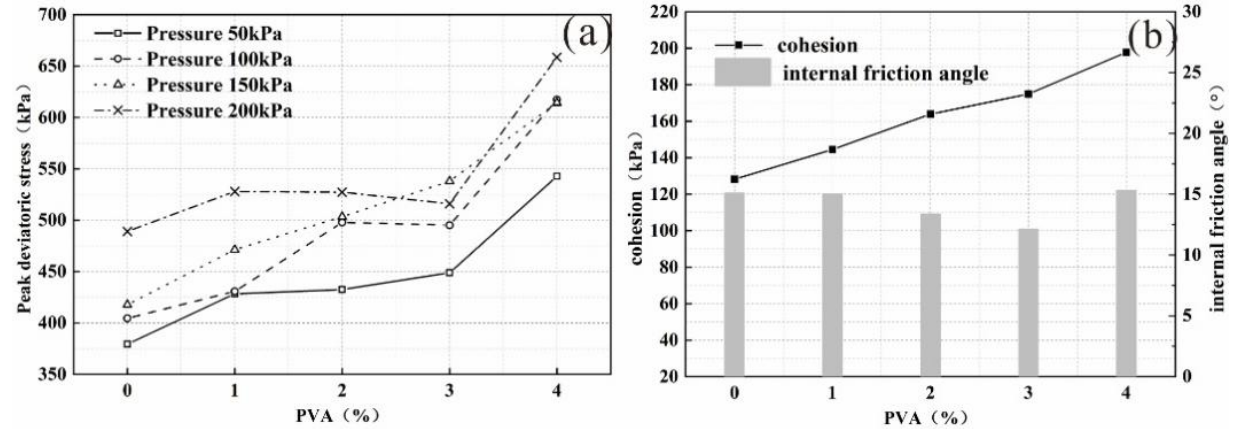
Figure 3. ( a ) The peak deviatoric stress; ( b ) cohesion and internal friction angle varied with PVA content.